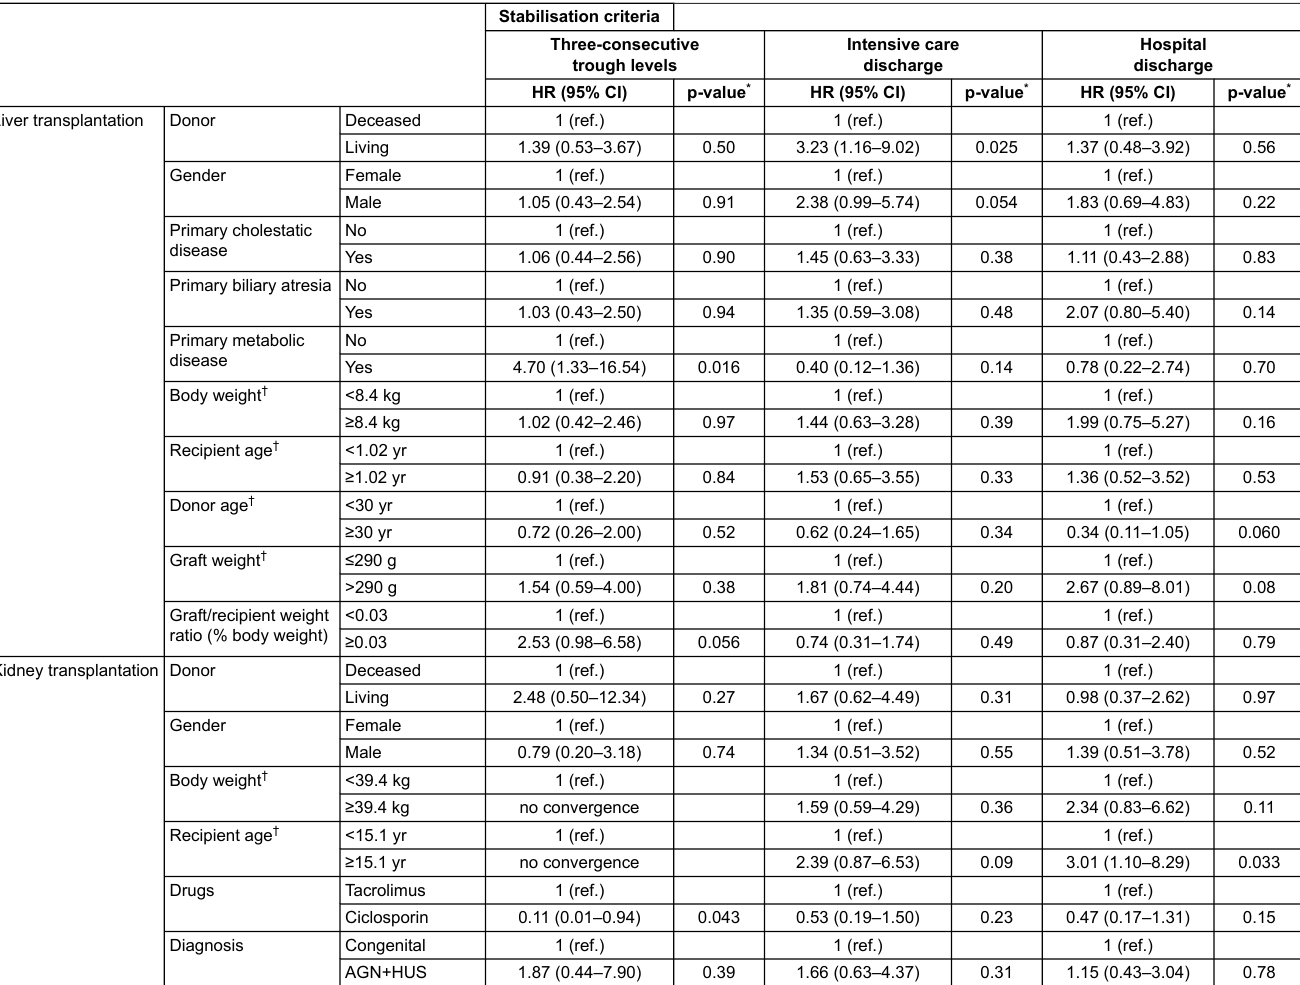
Table 2: Factors associated with trough level stabilisation at 30 days (univariate analysis).